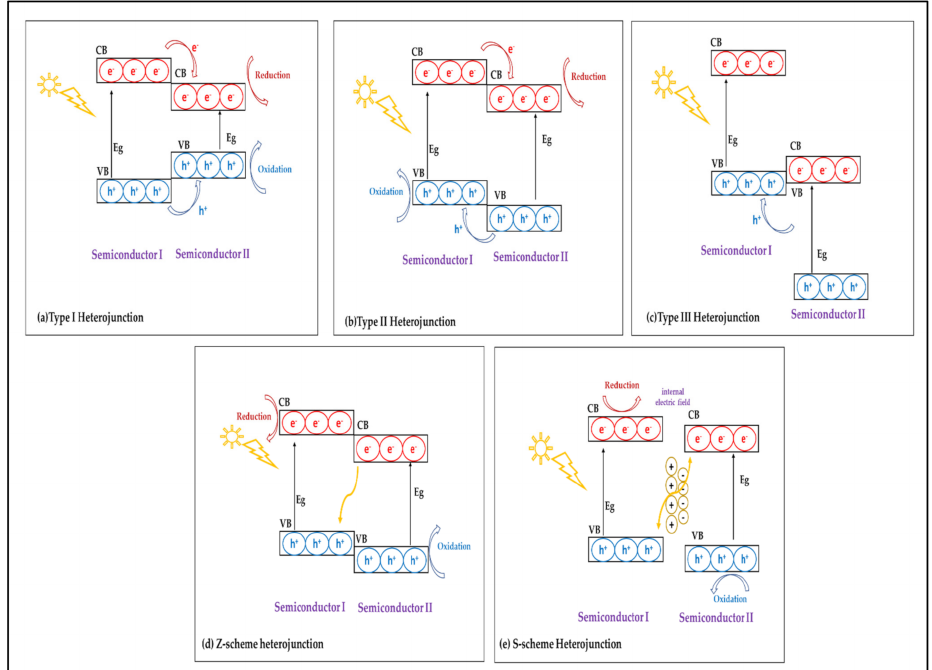
Figure 2. Schematic illustration of the band gap alignment of different types of